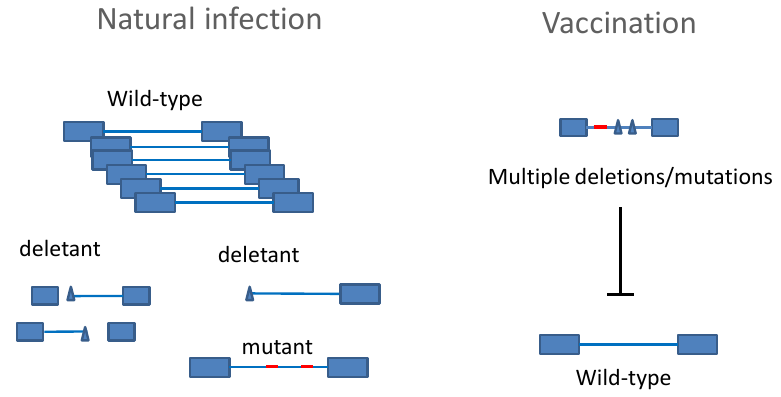
Figure 3. Vaccination strategy using an attenuated BLV strain. During chronic infection, mutations and deletions naturally occur in the BLV provirus, leading either to viruses with defective replication or to attenuated strains. This type of deletant or mutant provirus can be used as a vaccine, provided that it lacks pathogenicity and boosts all components of the anti-viral